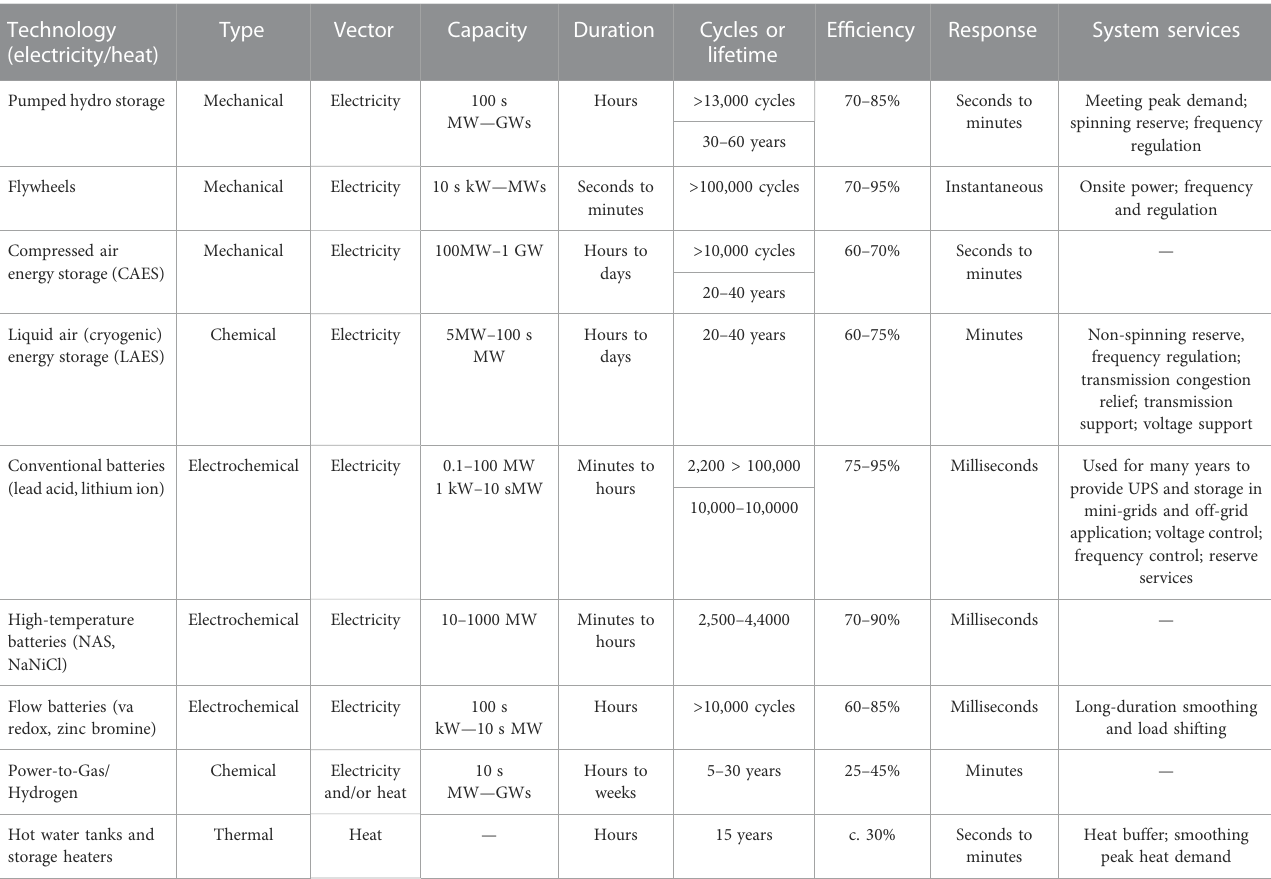
TABLE 1 Energy storage